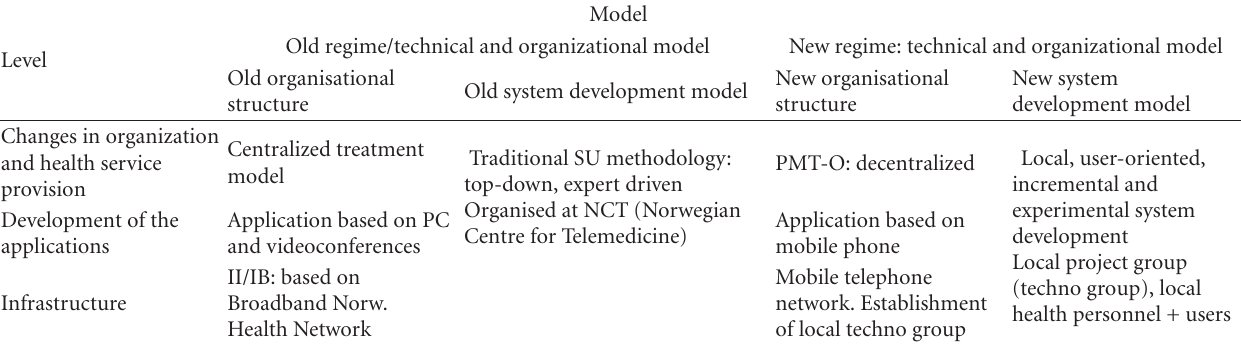
Table 4: Framework for old and new regime/technical and organisational